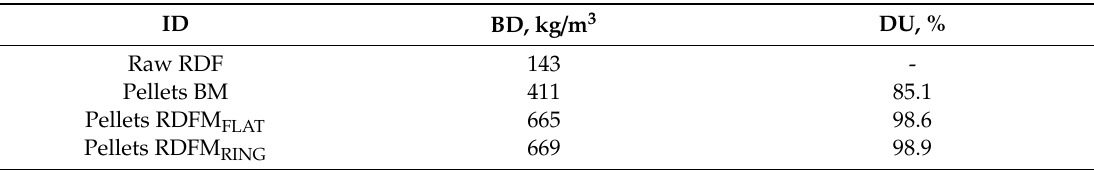
Figure 12. Variation of the mechanical durability with compaction pressure, temperature, and pellet diameter.